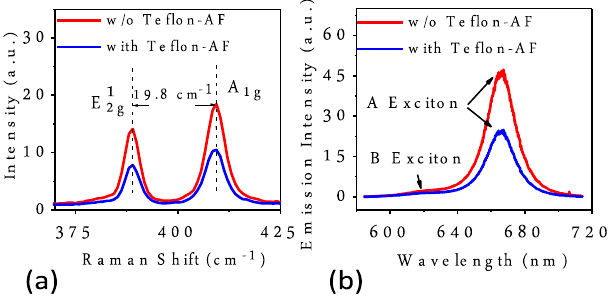
Figure 2. ( a ) Raman spectrum of MoS 2 before (red) and after (blue) applying Teflon-AF encapsulation layer; ( b ) photoluminescence (PL) spectrum of monolayer MoS 2 before (red) and after (blue) applying the cap.